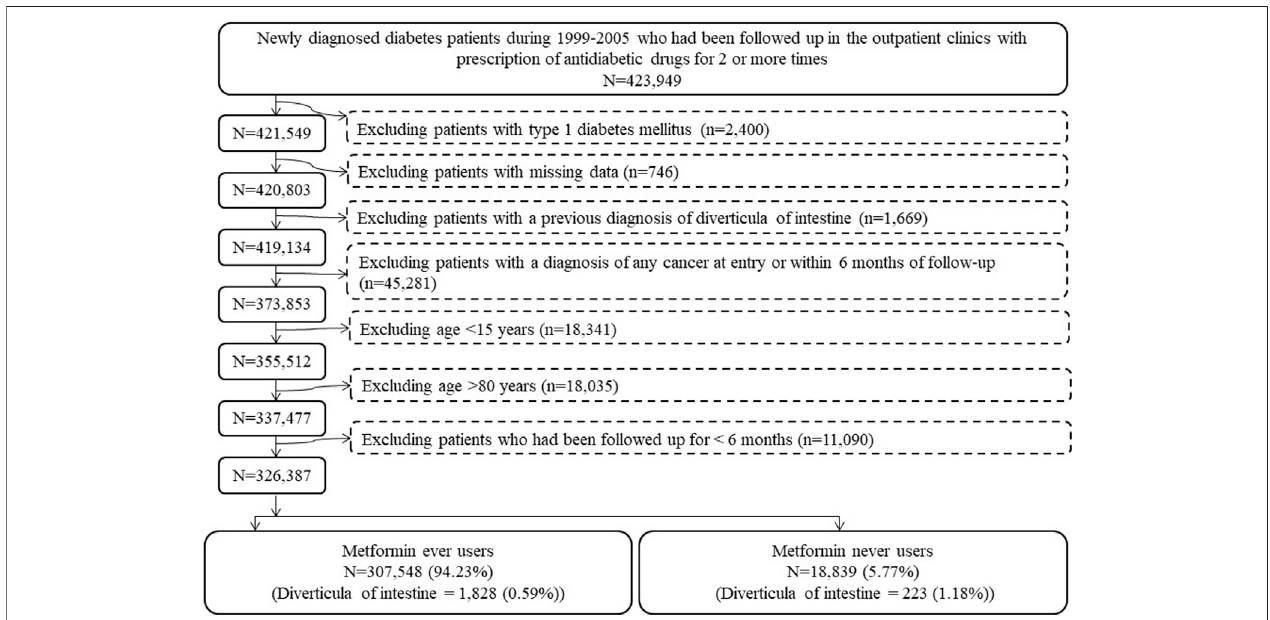
FIGURE1| Step-by-stepproceduresfollowedtocreatecohortsofeverusersandneverusersofmetforminfromtheTaiwan ’ sNationalHealthInsurancedatabase.